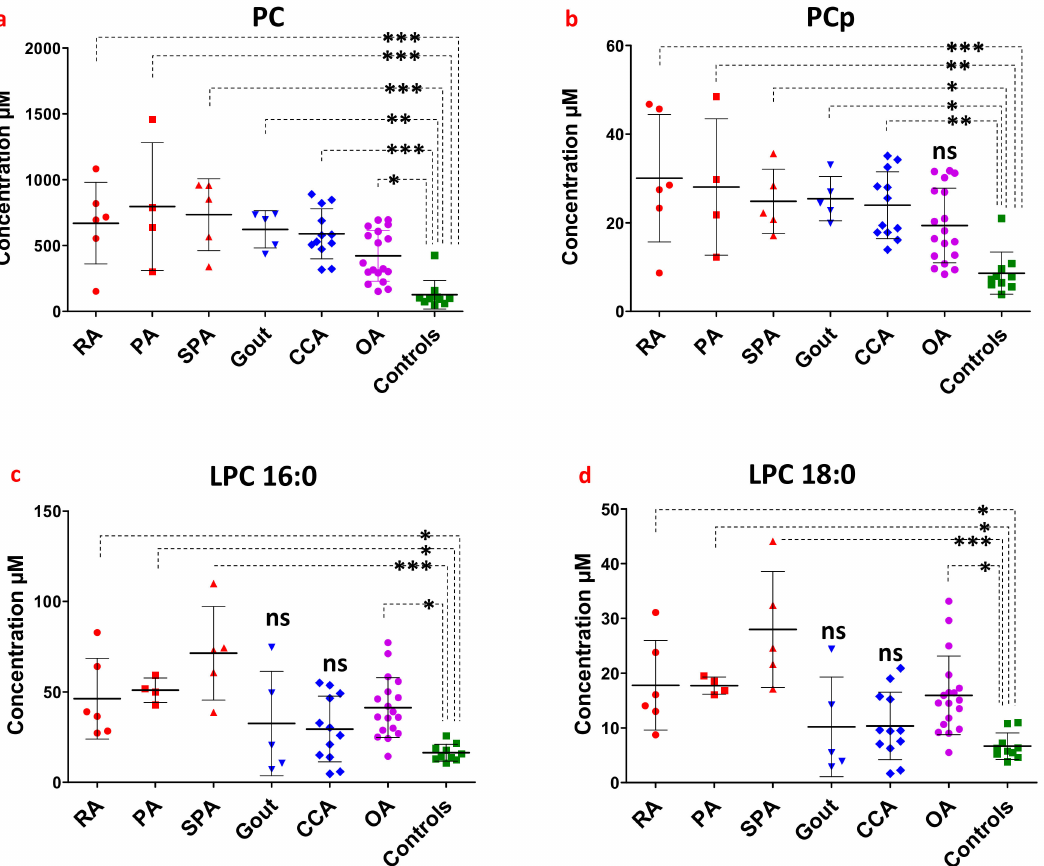
Figure 4. Evaluation of lipid concentrations in the synovial fluid of patients according to the rheumatic diseases associated with chronic joint pain. ( a – d ) Concentrations (in µ M) of PC, PCp, LPC16:0, and LPC18:0, respectively, in the synovial fluid of patients depending on joint pathologies: (RA, n = 6), (Gout, n = 5), (CCA, n = 12), (PA, n = 4), (SPA, n = 5), (OA, n = 18) and controls n = 10. The comparison between lipid concentrations in the individual joint pathologies was based on the one-way analysis of variance completed with Bonferroni’s Multiple Comparisons Test. ns: not significant p > 0.05, *: 0.01 < p < 0.05, **: 0.001 < p < 0.01 and ***: p <